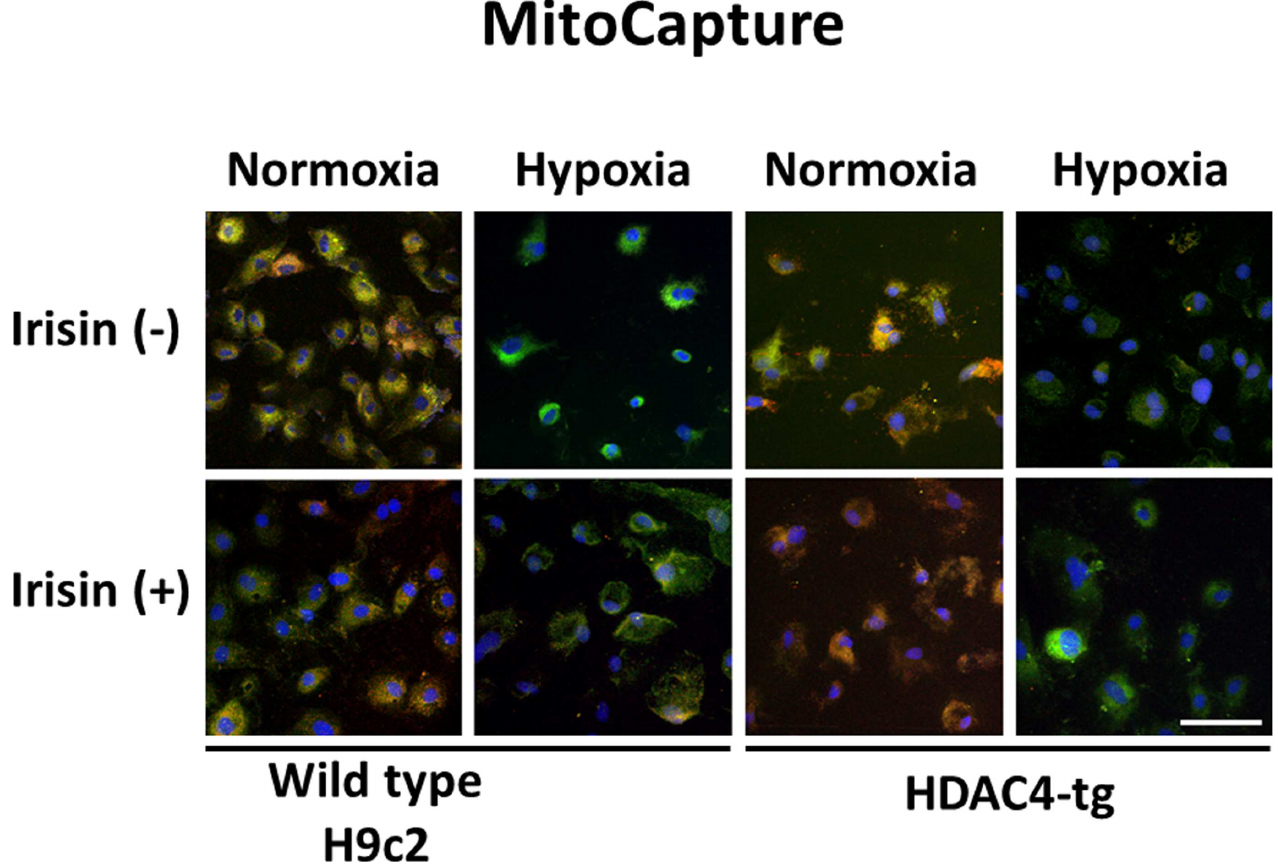
Fig 5. The effect of irisin on H/R induced MMP reduction in H9c2 cells. Cardiomyoblast mitochondrial damagewas assessed by examining mitochondrial membranedepolarization. The MitoCapturedye accumulates in the mitochondria under normoxiato emit a red signal. In apoptotic cells, the MitoCapturediffuses into the cytoplasm and emits a green signal.ExposingH9c2 cells to H/R caused a significantdecrease in the ratio of red to green fluorescence intensity, which is a sign of the early stages of cell apoptosis.Apoptosis was more severe in the HDAC4 group. However, irisin treatment improvedthe H/R-led MTP loss significantly in both WT cells and HDAC4 over-expression cells. The bar represents100 μ m.